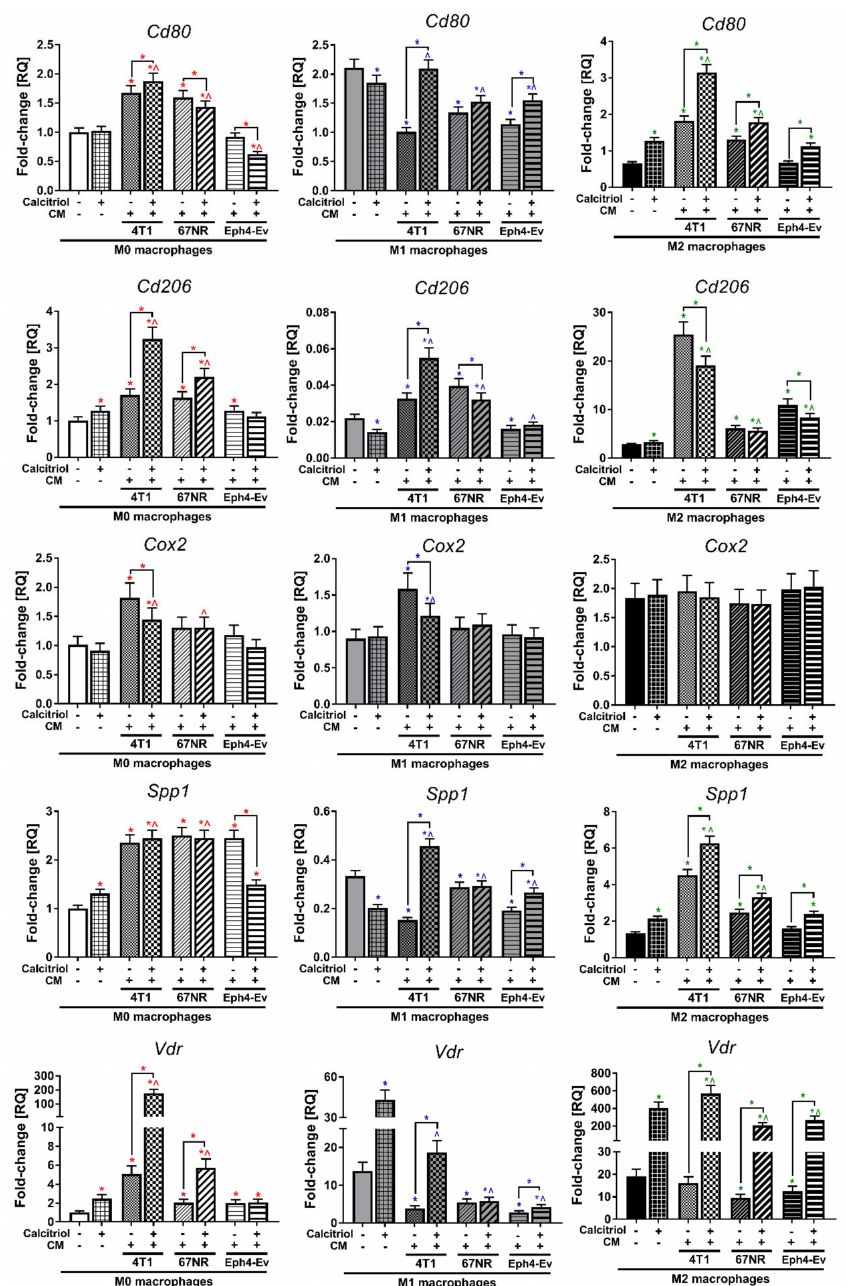
Figure 6. Expression of selected genes in various BMDMs classes, stimulated with CM, with or without calcitriol analyzed by real-time PCR. In general, 4T1 CM showed the highest influence on the